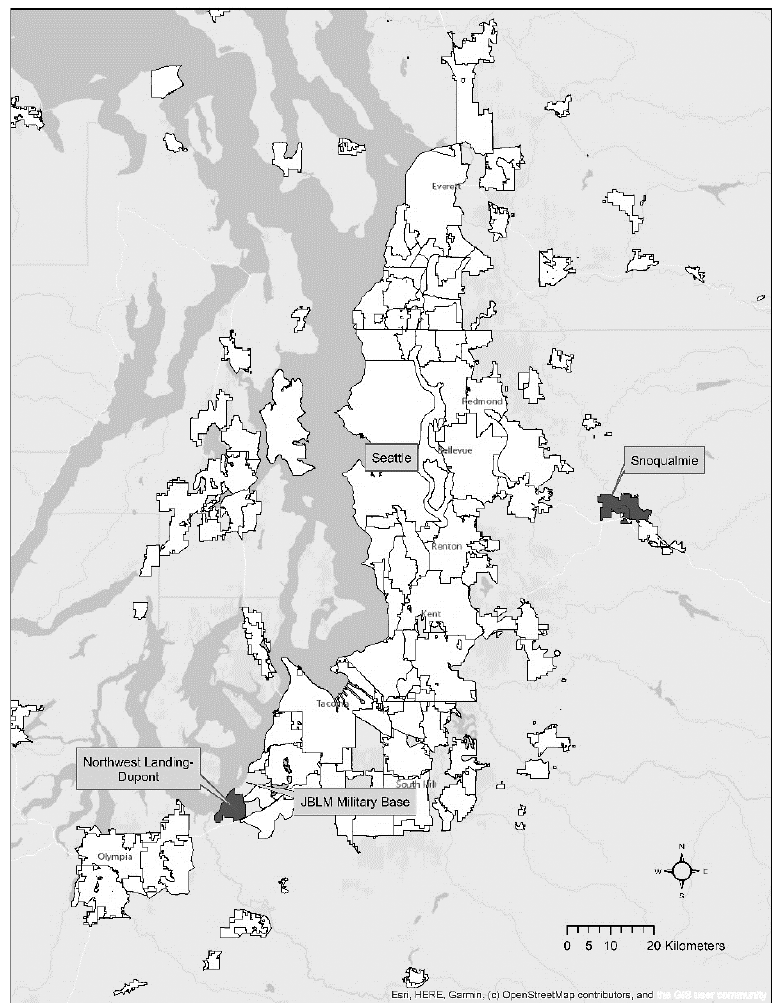
Figure 2. New Urbanist case studies in city-regional context. Source: